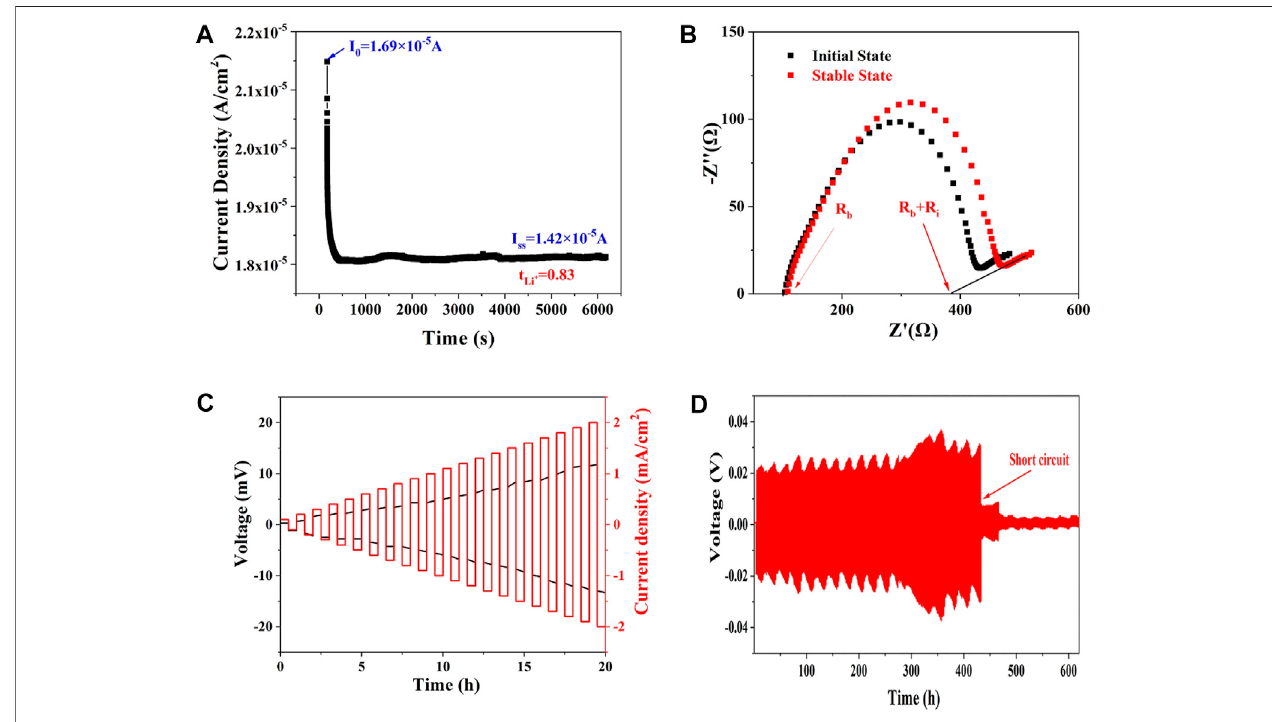
FIGURE4 | The time-currentcurve ofLi/SSE/Li symmetric cell under 10 mV (A) , theNyquistplots ofthe cell at initial and steady states (B) , and polarization curves of the Li/SSE/Li symmetric cell under different current densities (C,D) .